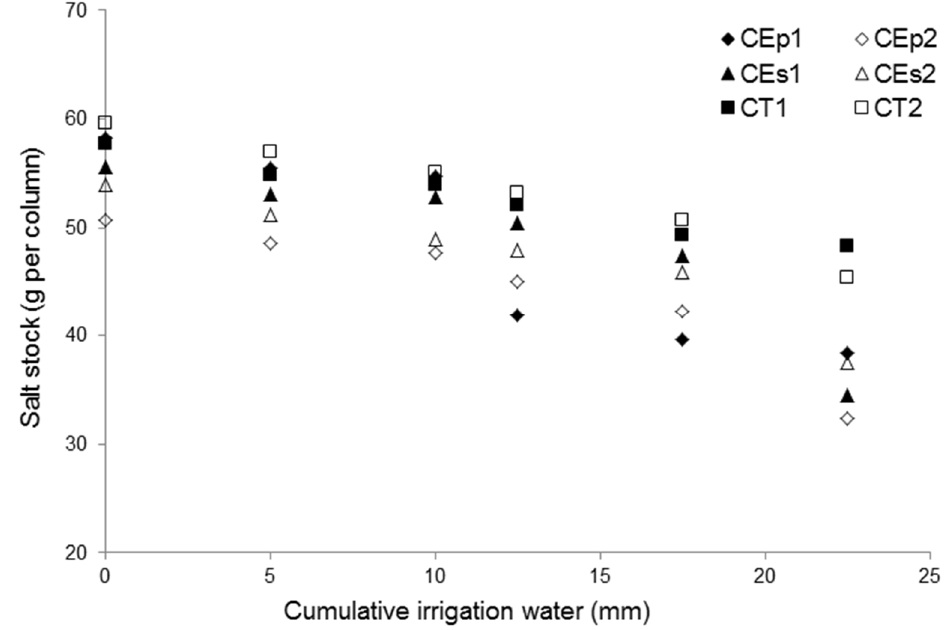
Figure 6. Relationship between cumulative irrigation and the soil salt stock in soil columns for the three treatments during the intercropping season. CEp1 and CEp2 are the columns cultivated permanently with E. stagnina , CEs1 and CEs2 are the columns cultivated with seasonal E. stagnina , CT1 and CT2 are the columns with bare soil.